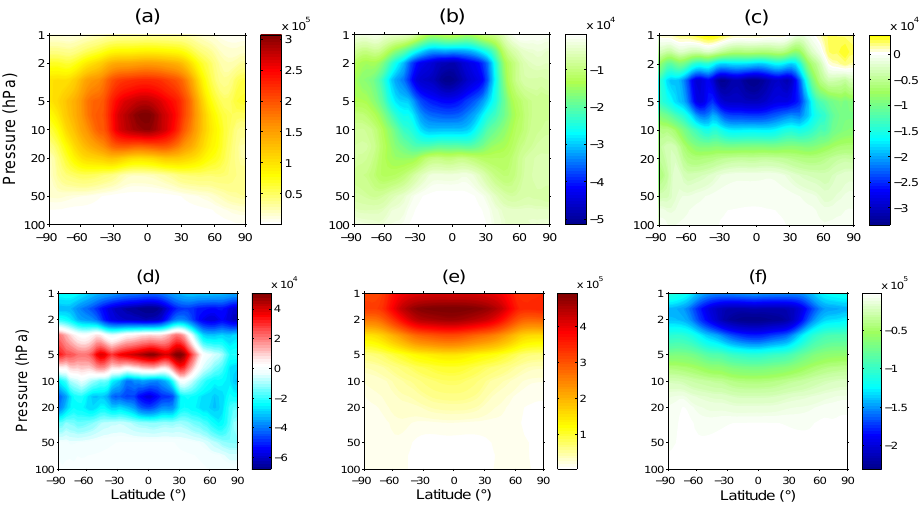
Fig. 3. (a) Contribution to ozone loss (moleculescm − 3 s − 1 ) from the nitrogen cycles as a function of pressure and latitude in the 2090s decade in the N 2 O-8.5 simulation, minus the same quantity for the N 2 O-2.6 simulation. (b) Same as (a) , but for the hydrogen cycles. (c) Same as (a) , but for the chlorine cycles. (d) Contribution to ozone loss from the nitrogen cycles as a function of pressure and latitude in the 2090s decade in the CH 4 -8.5 simulation, minus the same quantity for the CH 4 -2.6 simulation. (e) Same as (d) , but for the hydrogen cycles. (f) Same as (d) , but for the chlorine cycles. Note the different orders of magnitude on the colour scales.